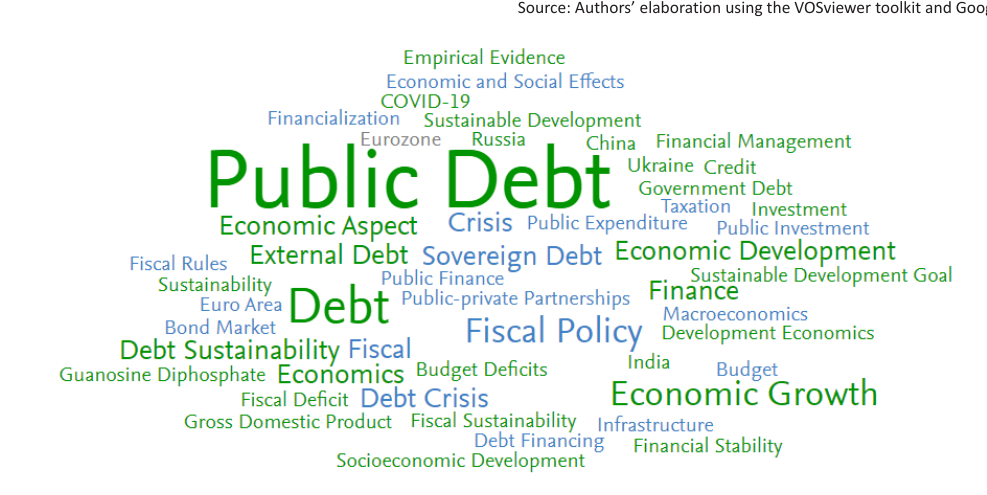
Figure 4. Top 50 keywords by relevance, based on publications on the topic “public debt” (green and purple clusters). There are intersections